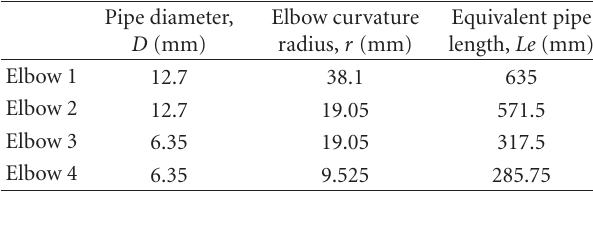
Table 1: Configurations of elbows used in the study.